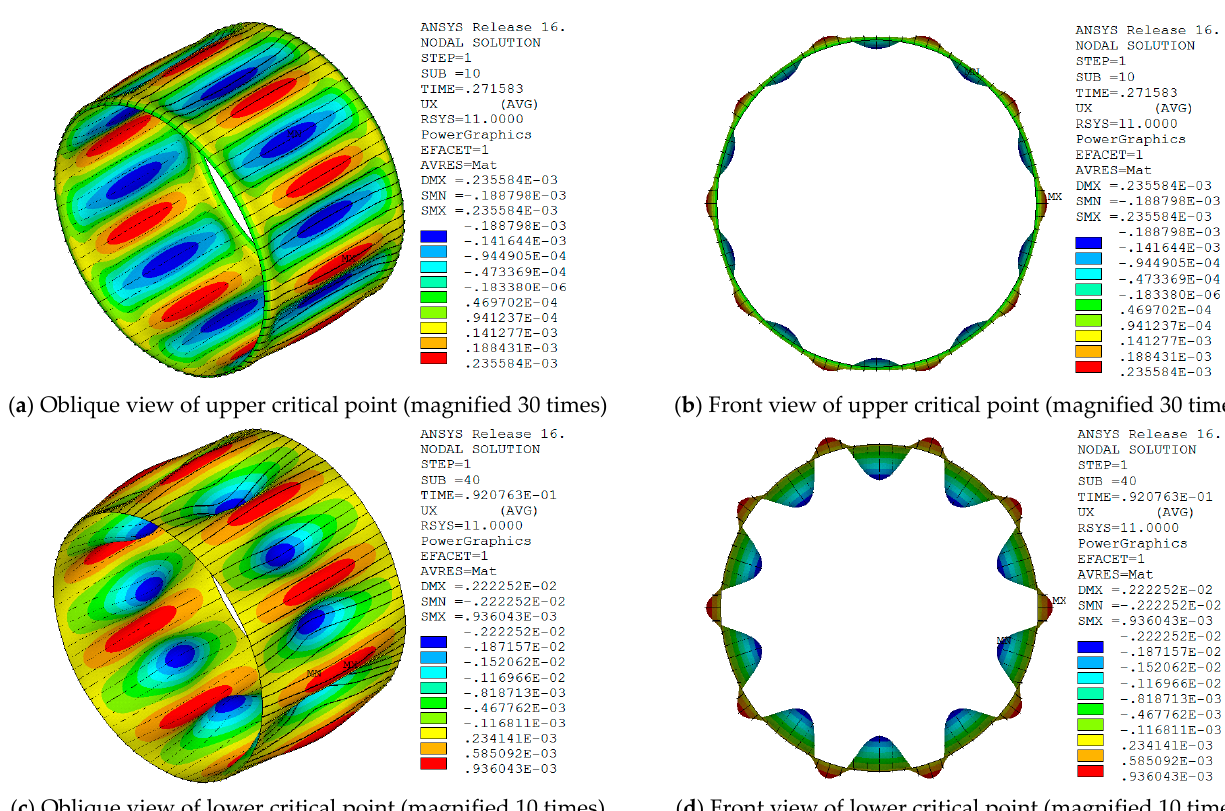
Figure 19. Radial displacement contour map at the critical points of the post-buckling path for the model with the SS3 boundary condition when the material of the model is PVC and ξ = 0.1.